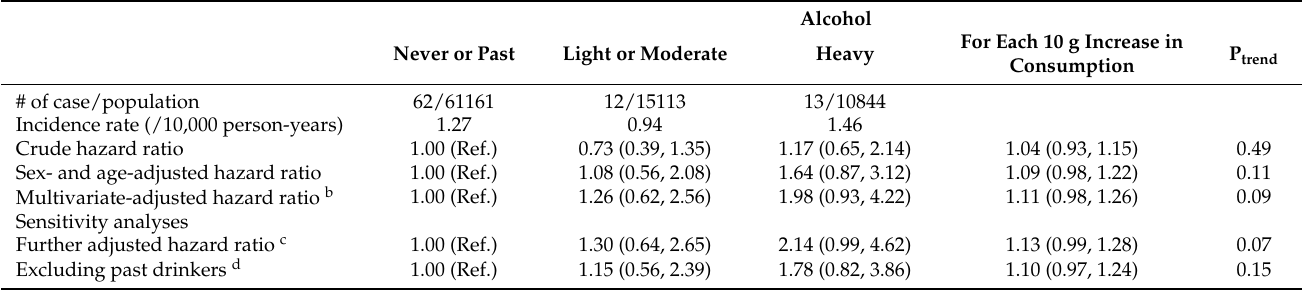
Table 2. Adjusted hazard ratio and 95% confidence interval for risk of rheumatoid arthritis by baseline alcohol consump- tion group a .